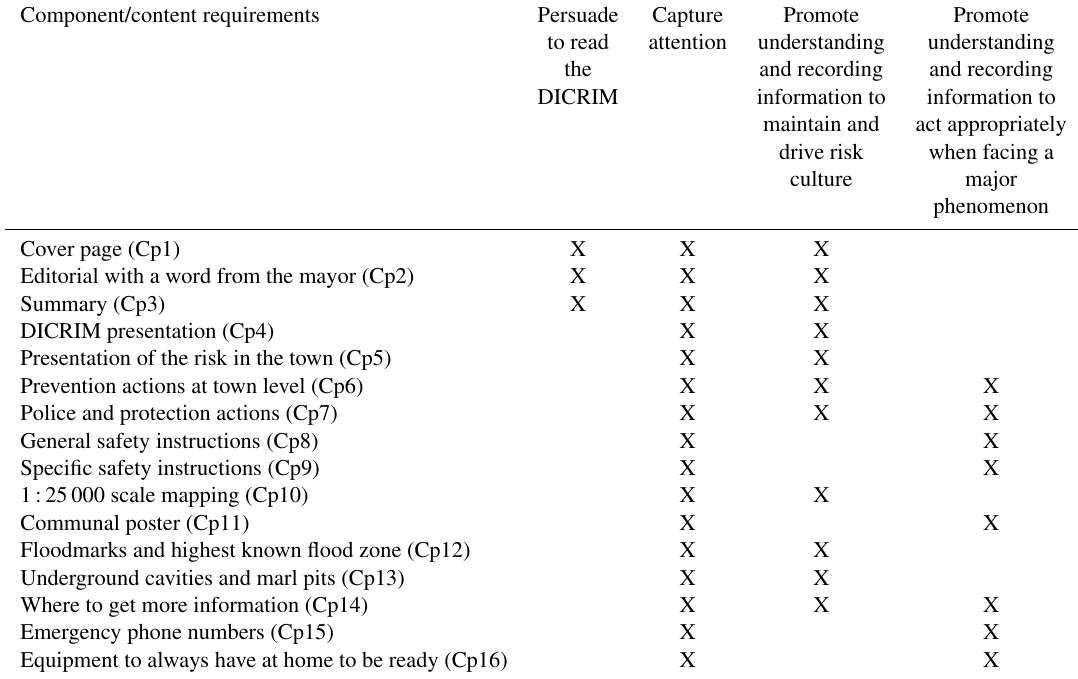
Table 6. An extract of some content requirements satisfied by each component. Component/content requirements Persuade Capture Promote Promote